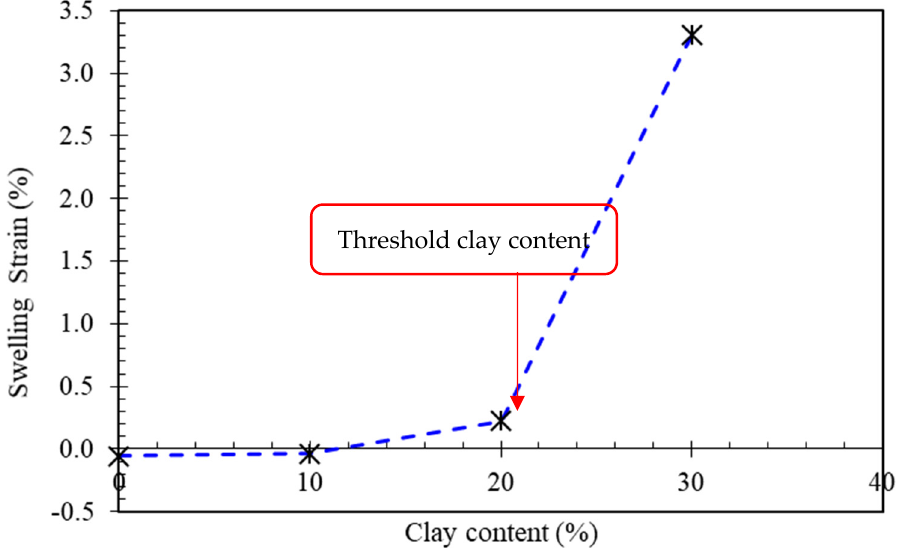
Figure 5. Swelling strain at 24 h vs. clay content of the sand–clay mixtures.